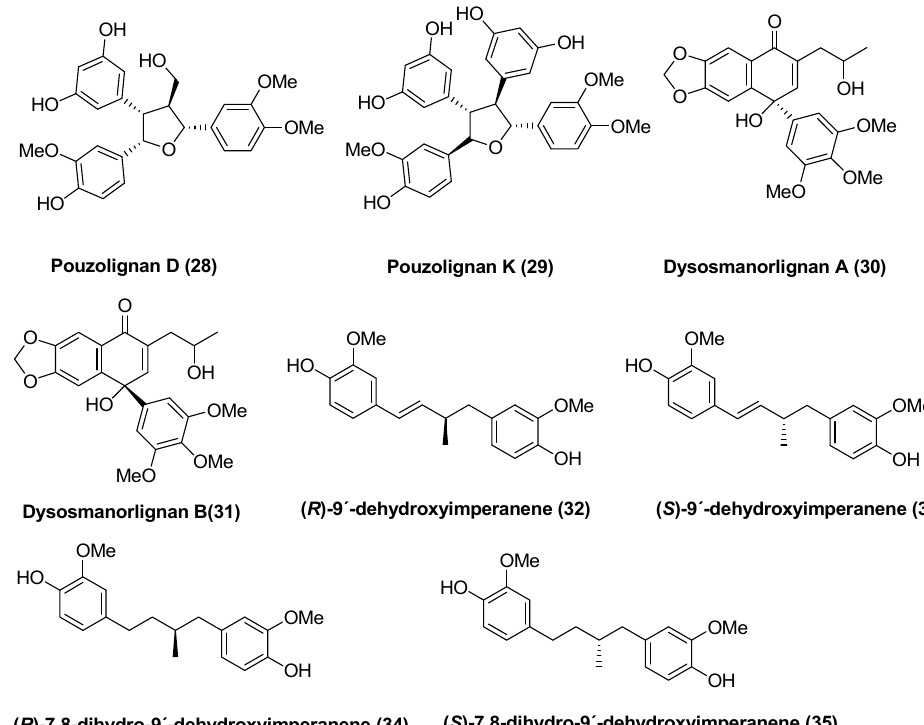
Figure 3. Structures of synthetic 9-norlignans and 9-norlignan related compounds.